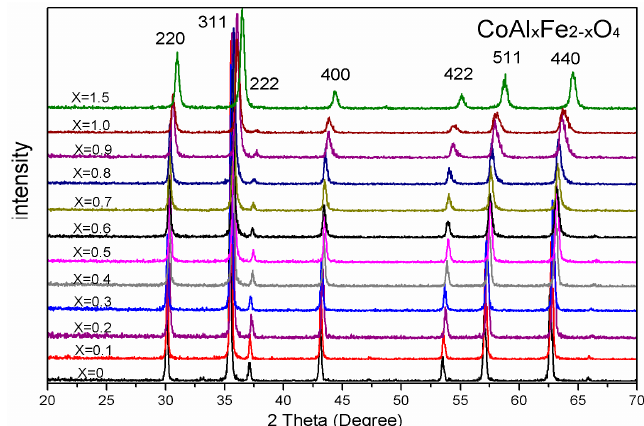
Figure 1. X-ray diffraction ( XRD) patterns of CoAl x Fe 2- x O 4 calcined at 1000 °C. Table 1. The XRD data of CoAl x Fe 2- x O 4 calcined at 1000 °C.